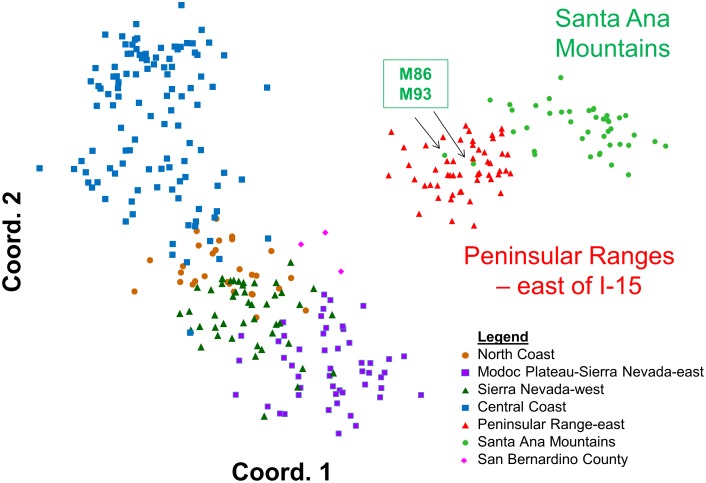
Principal Coordinates analyses (PCoA) constructed using genetic covariance matrices (GenAlEx) for 354 California puma genetic profiles including 97 from southern California.Patterns displayed for first two axes of variation within the genetic data set. Each point, color-coded to its sampling region, represents an individual puma. Note that colors in PCoA diagrams reflect geographic source of samples and not STRUCTURE genetic cluster assignment. Abbreviations and sample sizes per Table 1. Arrows denote pumas described in Figure 4.